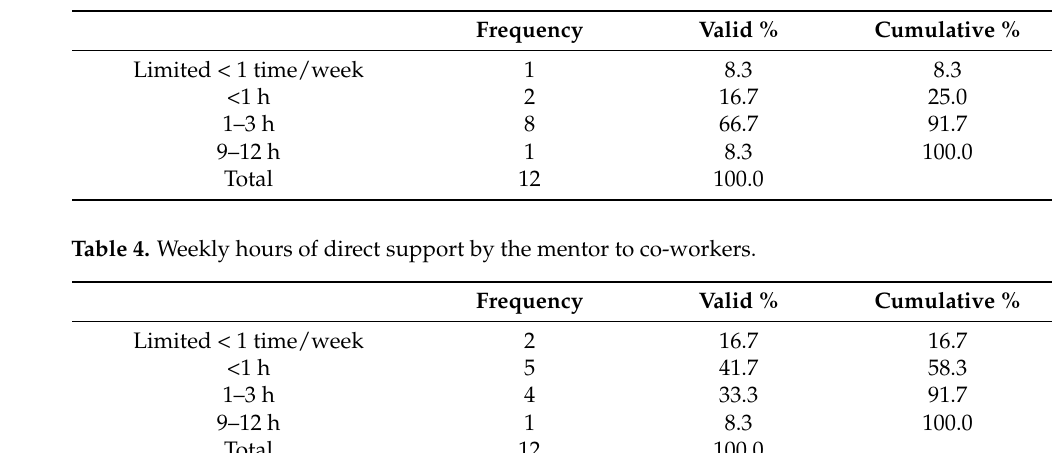
Table 3. Weekly hours of direct support by the mentor.